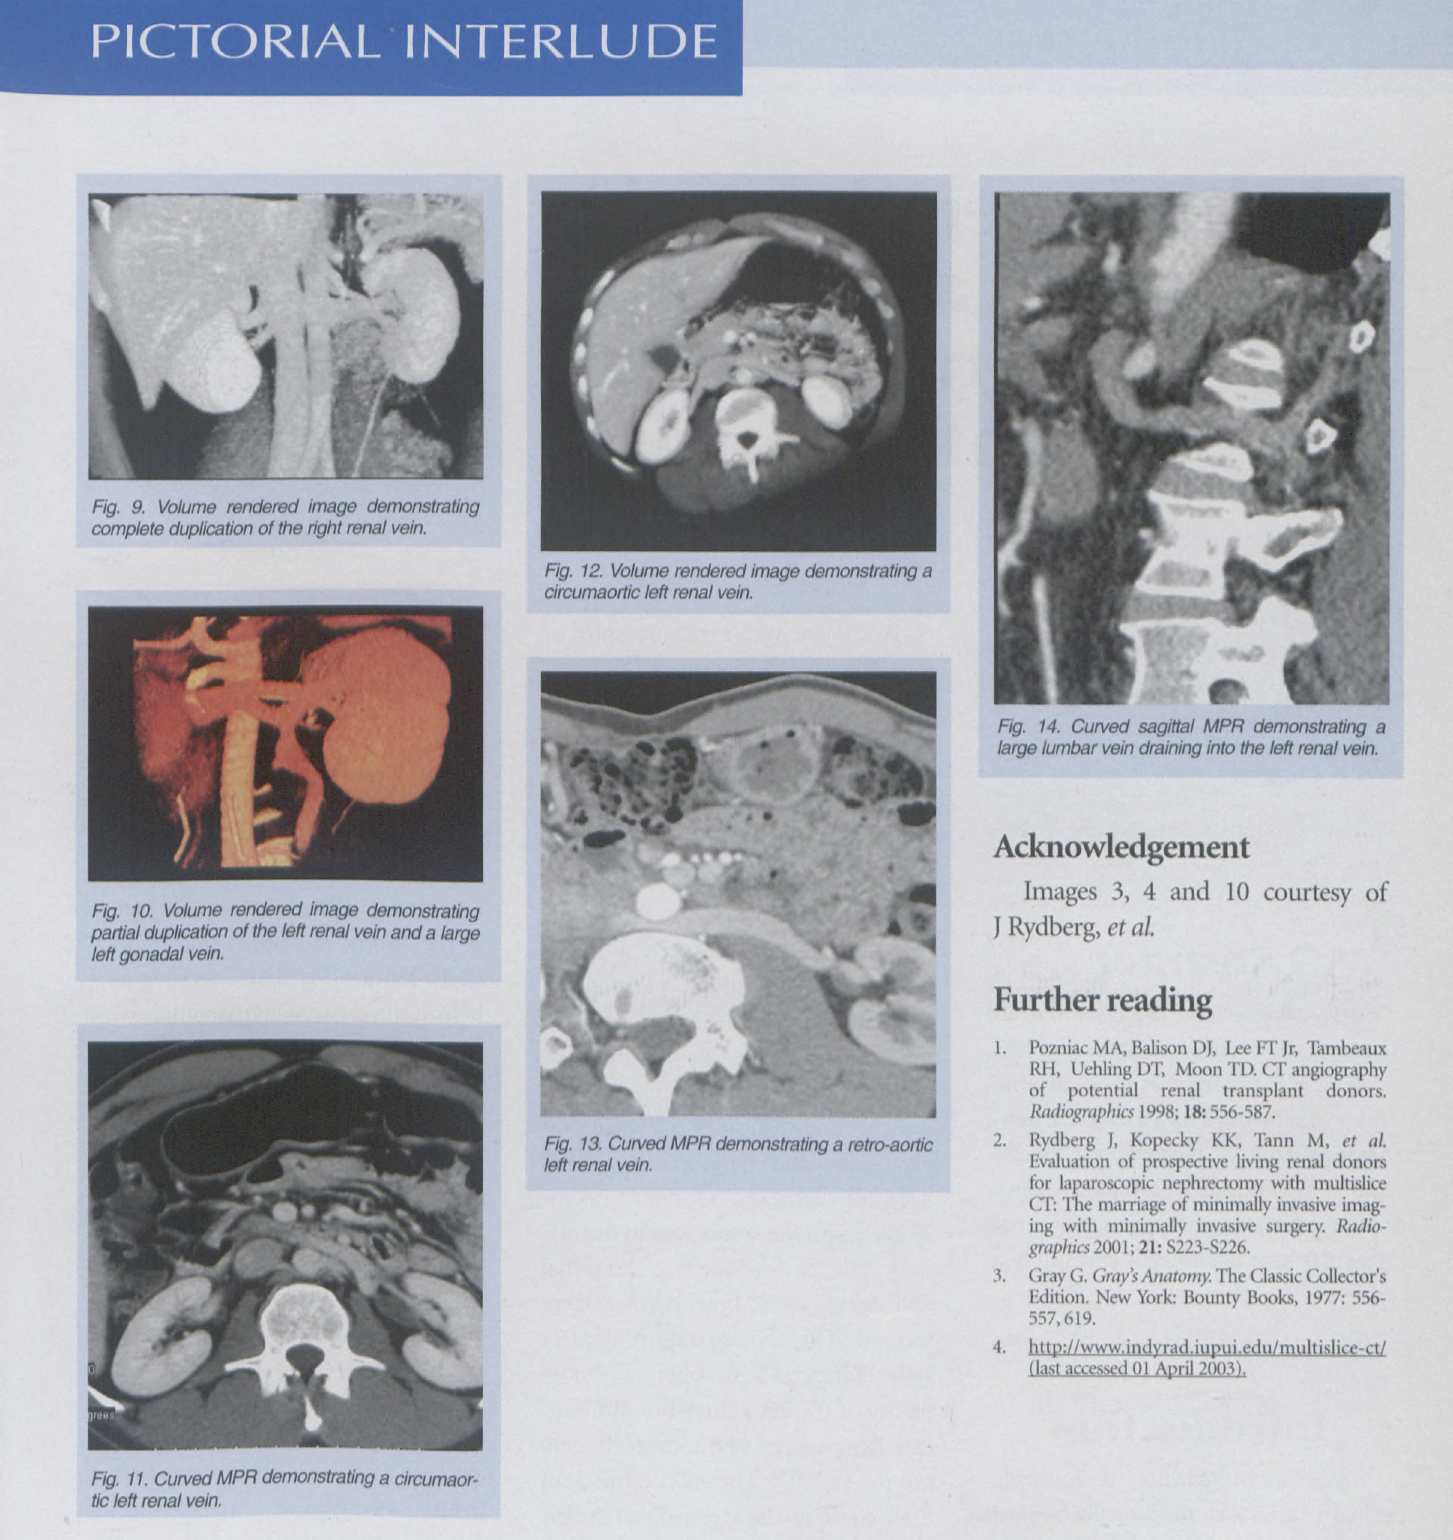
Fig. 11. Curved MPR demonstrating a clrcumeor- tic left renal vein.